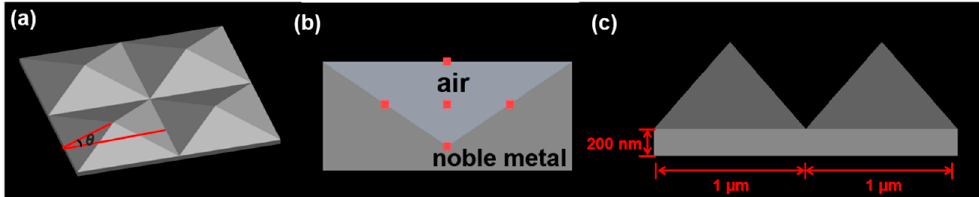
Figure 3. Schematic diagram of the noble metallic nano-pyramidal template. ( a ) PPS model; ( b ) IPS model in the x–z plane; ( c ) side view of the pyramid array.